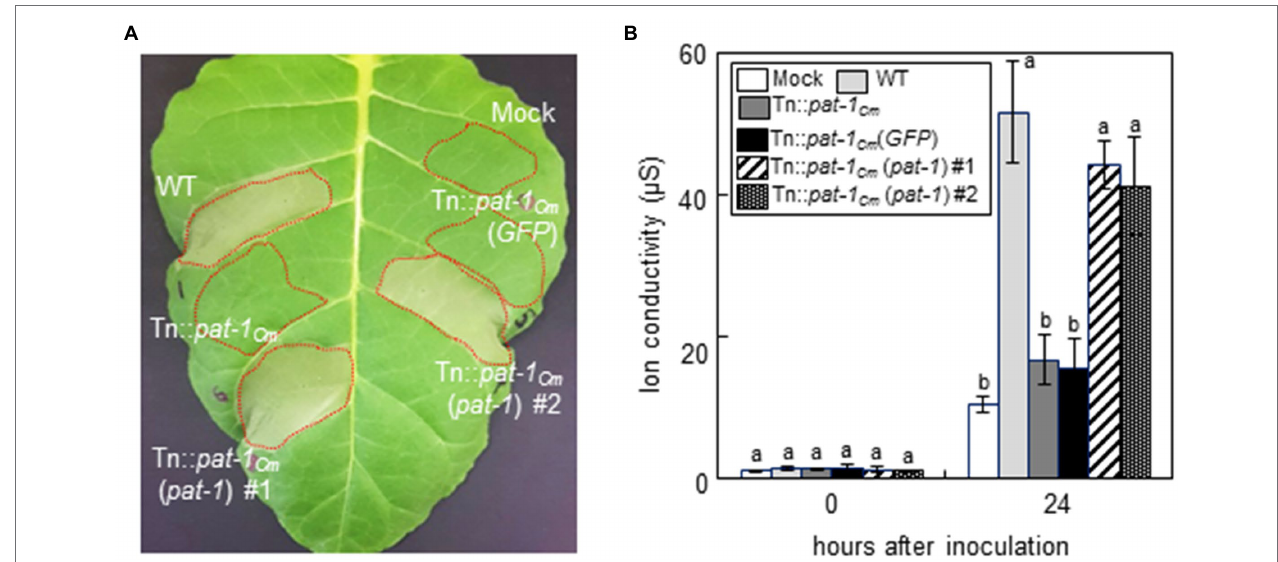
FIGURE 3 | Loss of hypersensitive response (HR)-eliciting activity of Clavibacter michiganensis mutant Tn:: pat-1 Cm in a nonhost plant, Nicotiana tabacum . (A) HR phenotype in N. tabacum after infiltration with the indicated strains. Mature leaves of 5-week-old plants were infiltrated, and a representative leaf was photographed 36 h after infiltration (hai). Red dotted lines indicate infiltrated regions. (B) Ion conductivity in leaves infiltrated with the indicated strains. At 0 and 24 hai, leaf disks were excised to measure electrolyte leakage. Error bars indicate SD ( n = 4). Different letters indicate statistically significant differences as determined by Duncan’s multiple range test ( p < 0.05). Mock, 10 mM MgCl 2 ; WT, C. michiganensis LMG7333 wild